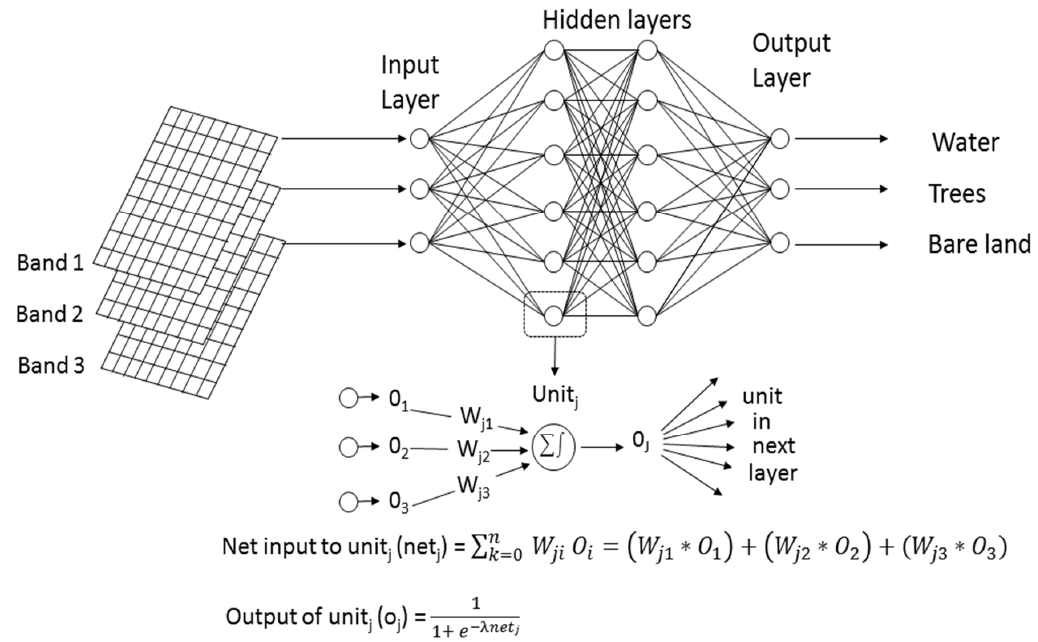
Figure 3. Classification of remote sensing data by an artificial neural network (adapted from Foody 1996) where W ij is the weight that connects the j th unit with its i th incoming connection; O i and O j are the value of the i th incoming connection and j th output connection; and λ is a gain parameter, which is often set to 1.